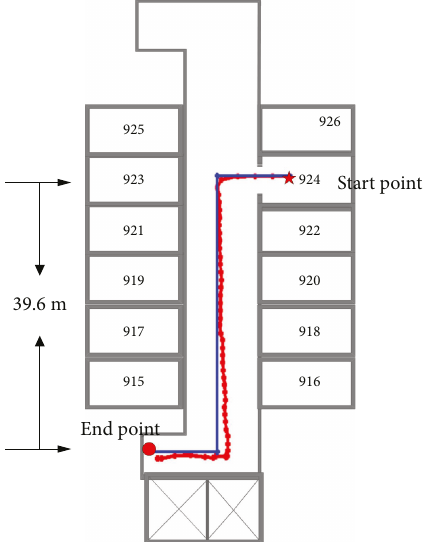
Figure 8: 2D plane trajectory optimized by the algorithm.